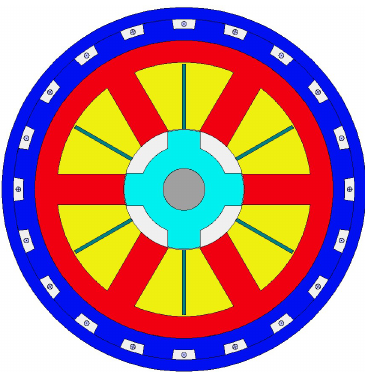
Figure 4. The method of cooling. The individual colors represent parts of the motor: dark blue— frame with cooling channels; red—stator sheets; yellow—stator winding; green—coil divider, insu- lation between coils; white—empty space, filled with water in the case of cooling channels or air in the case of the air gap between the rotor and stator; light blue—rotor sheets; grey—shaft.